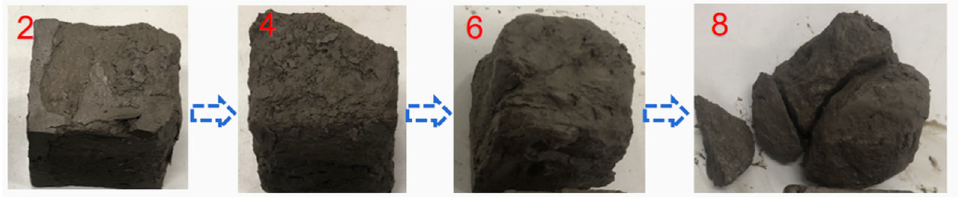
Figure 7. Appearance changes of specimens with 10% geopolymer content in wet–dry cycles. The number of cycles is 2, 4, 6, 8.